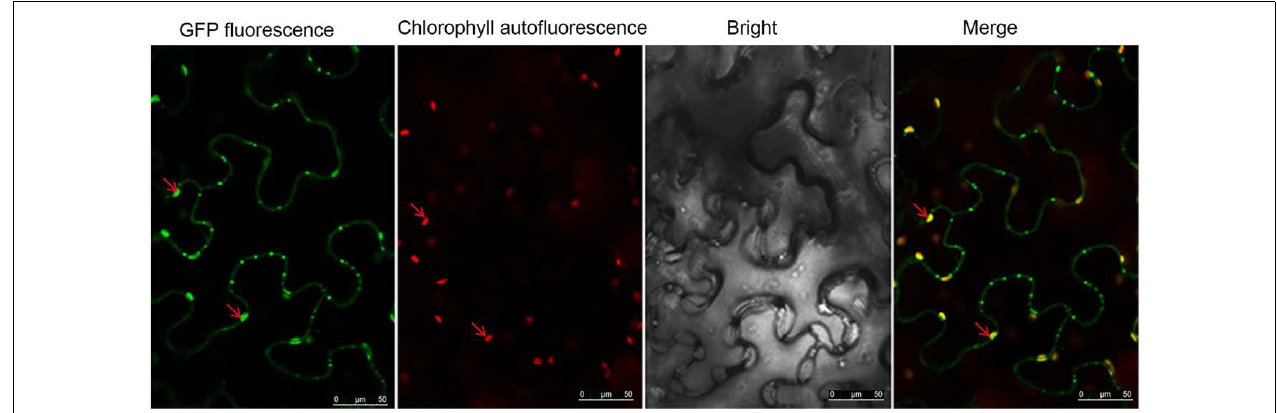
FIGURE 6 | NSvc4-eGFP expressed using the Potato virus X-based vector localized to chloroplasts. At 7 or 8days post inoculation with pgR-NSvc4-eGFP, systemically infected leaves were sampled and examined by confocal microscope. Arrows indicate the sphere-like compartments formed by NSvc4-eGFP fusion protein.